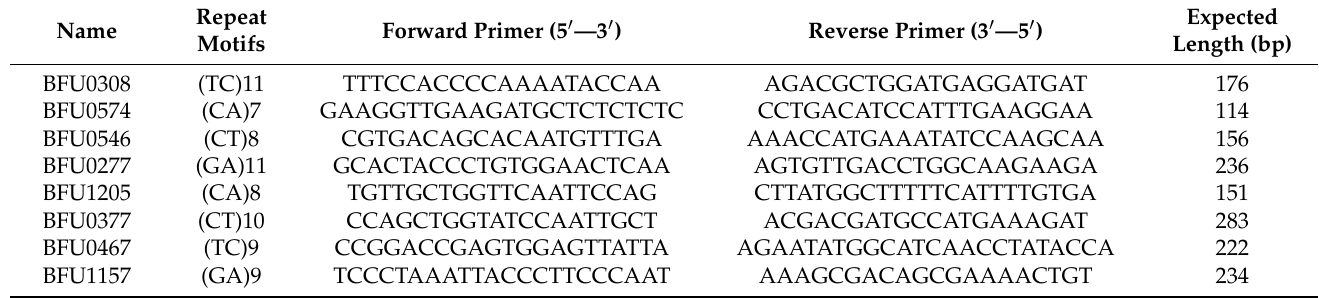
Table 2. SSR primer information